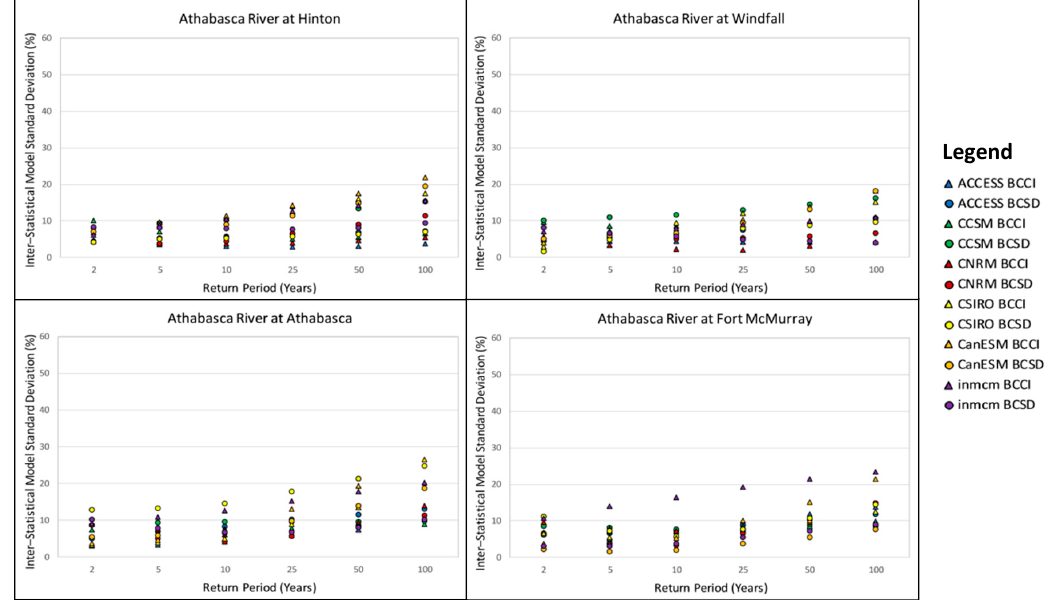
Figure 11. Inter-statistical model variability of projected changes in peak flow between the 2080s and the 1990s baseline period and the RCP8.5 emissions scenario corresponding to each of the GCM/SD considered.